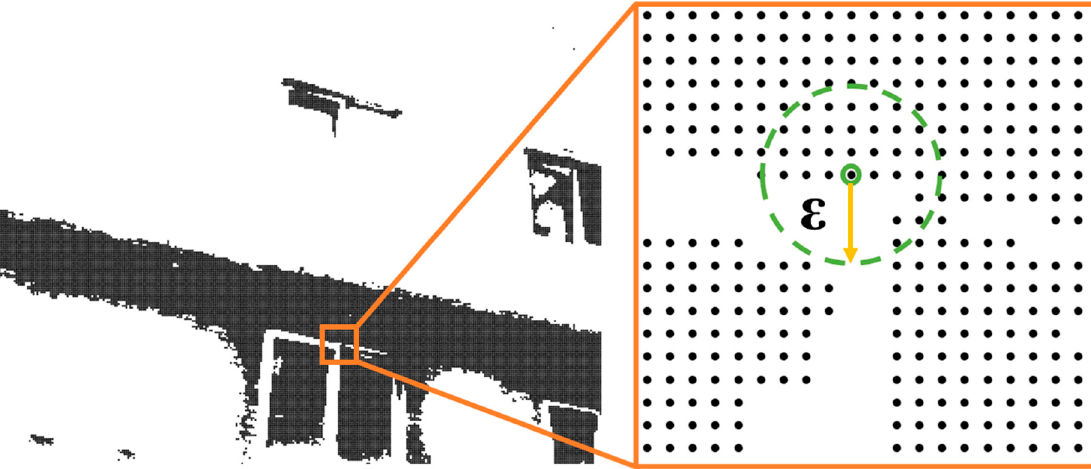
Figure 4. Thermal anomaly clustering based on Density-Based Spatial Clustering of Applications with Noise (DBSCAN).